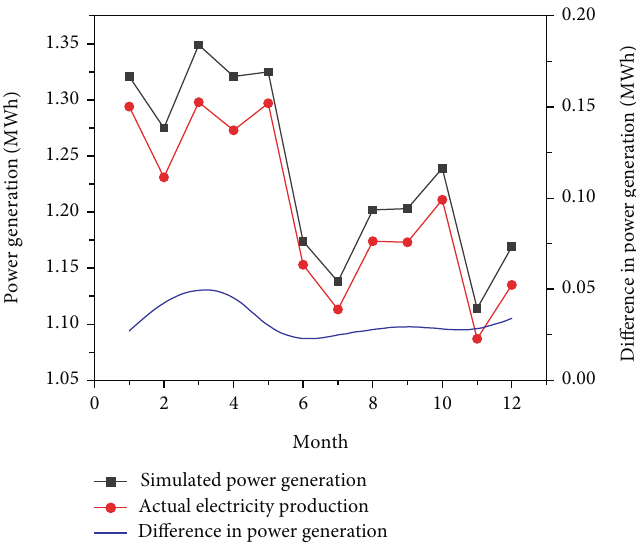
Figure 11: Comparison diagram of annual power